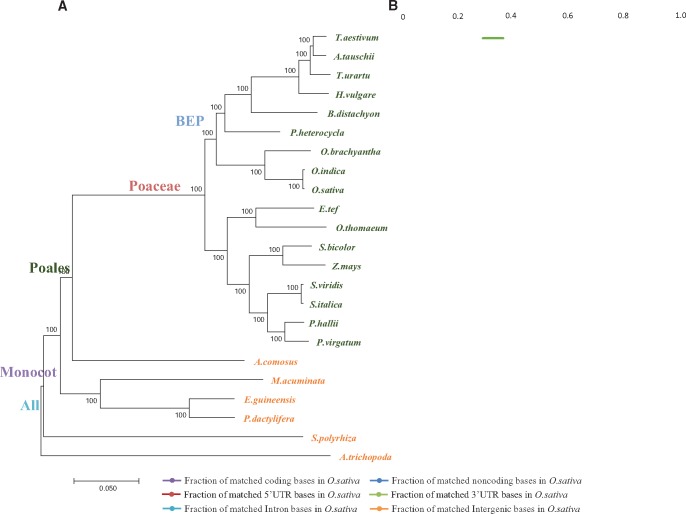
—Phylogenetic tree and base pair coverage based on conserved sequences. (A) The phylogenetic tree obtained using shared sequences that are aligned across all genomes. (B) Base pair coverage for coding sequence (CDS) and noncoding regions based on the annotated rice gene models.